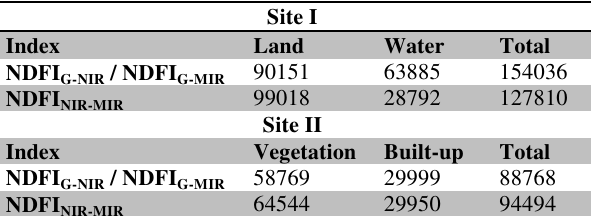
Table 2. Reference points for Site I and Site II